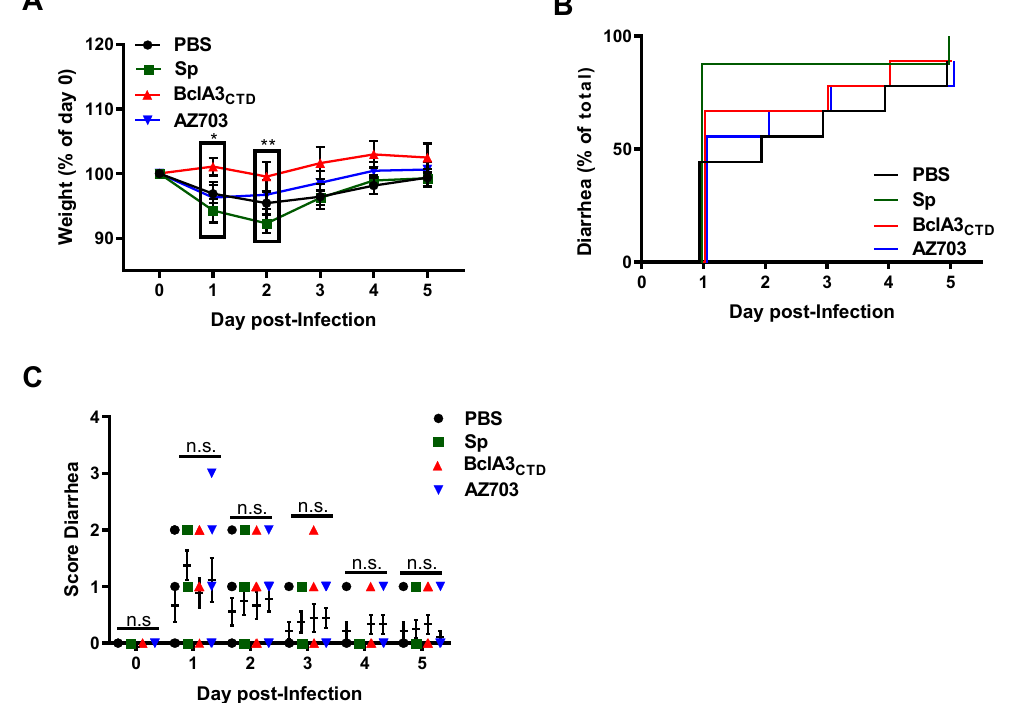
Figure 5. Protective efficacy of intranasal administration of BclA3 CTD and AZ703 against CDI in a murine model. C57BL/6 mice were nasally immunized with PBS, B. subtilis PY79 spores, purified BclA3 CTD or AZ703 spores and challenged with C. difficile R20291 spores. Mice were monitored in the